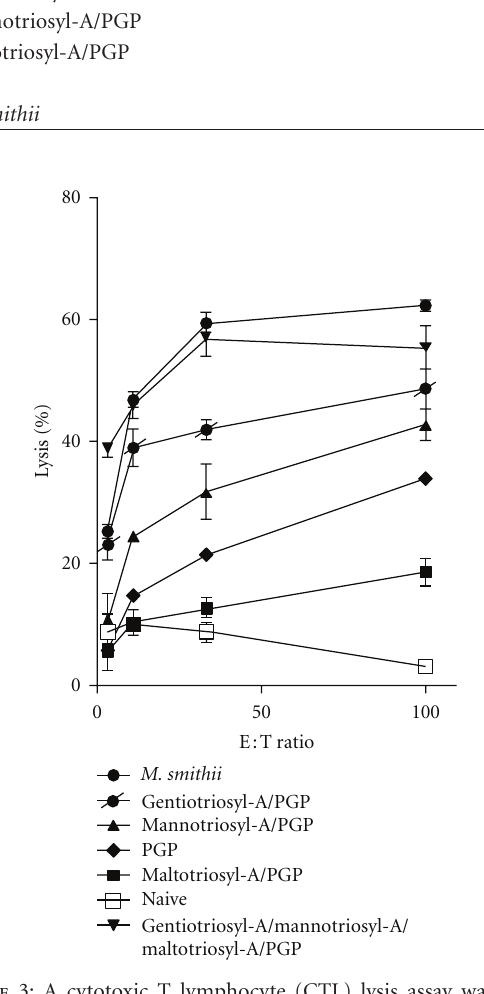
Figure 3: A cytotoxic T lymphocyte (CTL) lysis assay was used to assess the same populations of splenic cells as in Figure 1. The standard 51 Cr assay was conducted using specific and nonspecific target cells (EG.7 and EL-4, resp.). The ratio of e ff ector splenic cells to target cells is shown as the E:T ratio in the graph. Results shown are for EG.7 targets. EL-4 targets produced only low nonspecific responses (not shown).